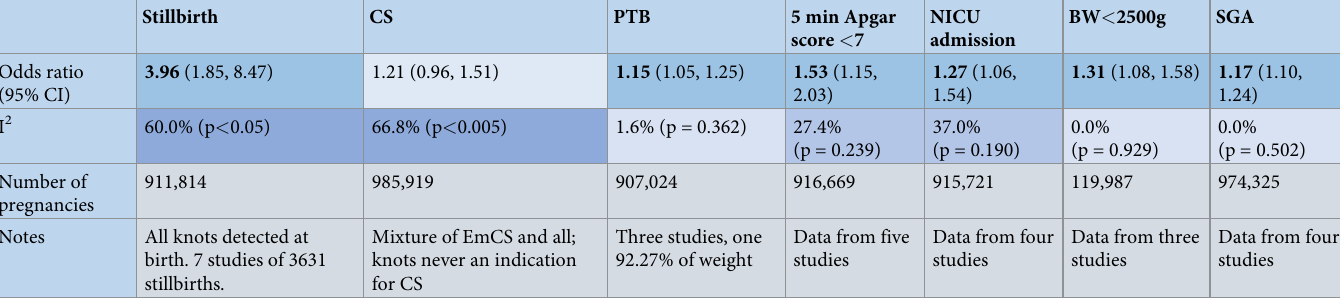
Table 3. Analyses of the relationship between true knots and adverse